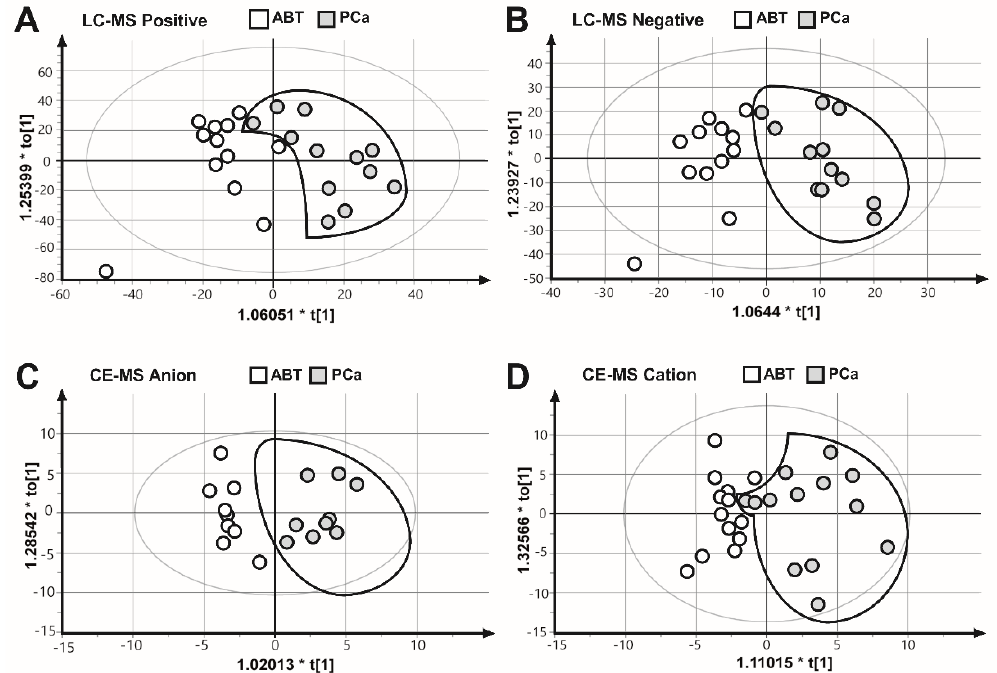
Figure 2. Comparison of the metabolite fingerprints of prostate cancer (PCa) and adjacent benign tissues (ABT) through orthogonal partial least squares discriminate analysis (OPLS–DA). OPLS–DA scores plot of ( A ) LC–MS ESI positive mode R2X = 0.394, R2Y = 0.648, Q2 = 0.189. ( B ) LC–MS ESI negative mode, R2X = 0.250, R2Y = 0.779, Q2 = 0.0649. ( C ) CE–MS anion mode, R2X = 0.247, R2Y = 0.875, Q2 = 0.581. ( D ) CE–MS cation mode, R2X = 0.372, R2Y = 0.663, Q2 = 0.136.